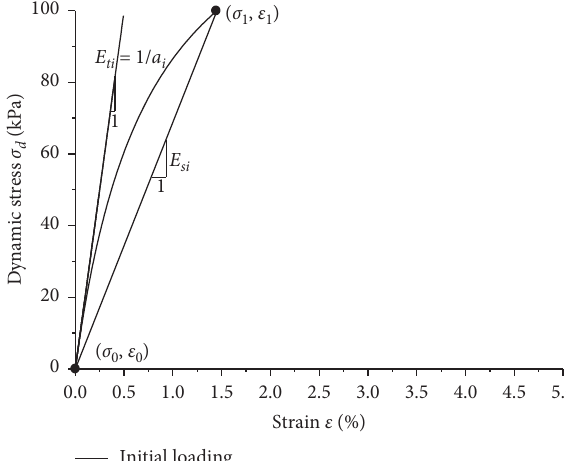
Figure 5: Significance of the parameter a stage.